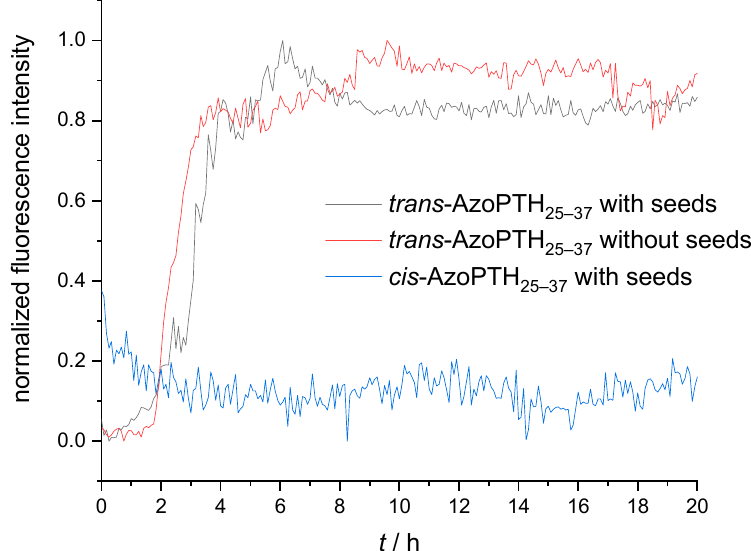
Figure 8. ThT-monitored fibrillization assay of cross-seeding studies with cis -AzoPTH 25–37 and trans -AzoPTH 25–37 monomeric peptides and mature trans -AzoPTH 25–37 fibrils as seeds (average of triplets; c monomer = 100 μ M, c seed = 20 μ M, T = 37 °C, buffer 50 mM Na 2 HPO 4 , pH = 7.4): (black) trans -AzoPTH 25–37 with seeds, (red) trans -AzoPTH 25–37 without seeds, and (blue) cis -AzoPTH 25–37 with seeds.